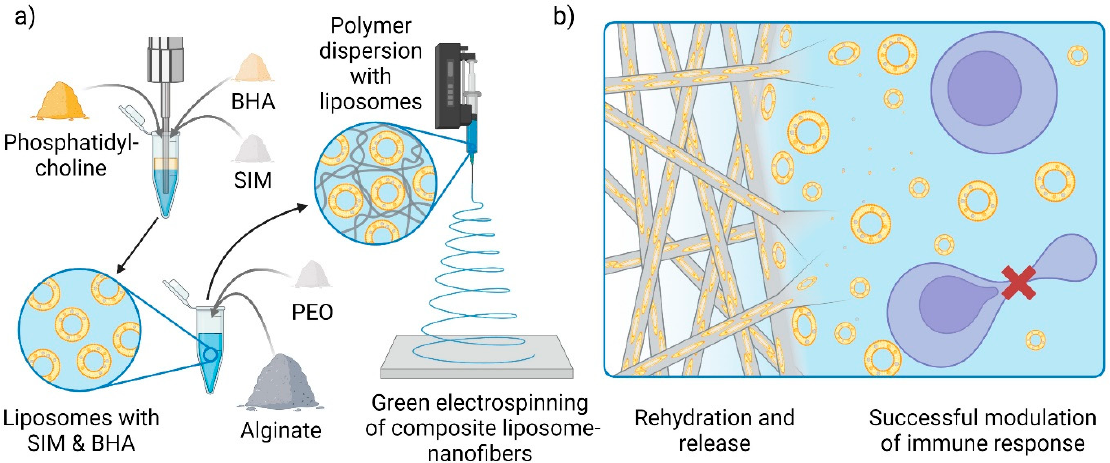
Figure 1. Schematic representation of ( a ) the preparation of the composite liposome nano fi bers and ( b ) reconstitution of liposomes after nano fi bers hydration and their impact on T-cell receptor activation, consequently inhibiting T-lymphocyte proliferation.